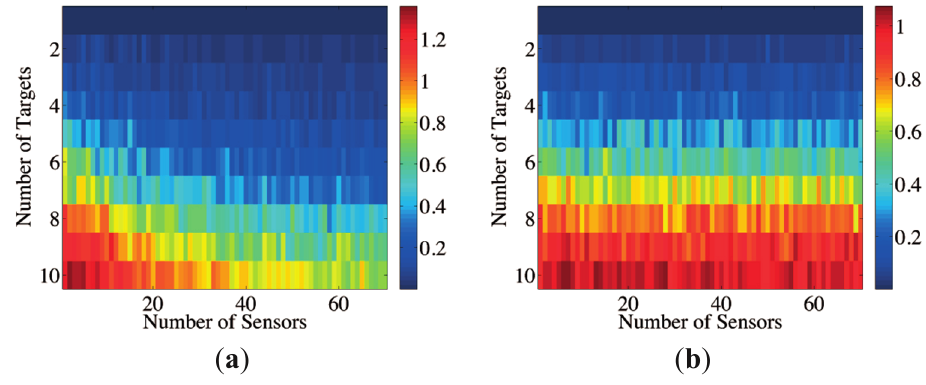
Figure 6. ( a ) Recovery errors w.r.t. numbers of targets and sensors with CS-MFP model; ( b ) Recovery errors w.r.t. numbers of targets and sensors with traditional MFP